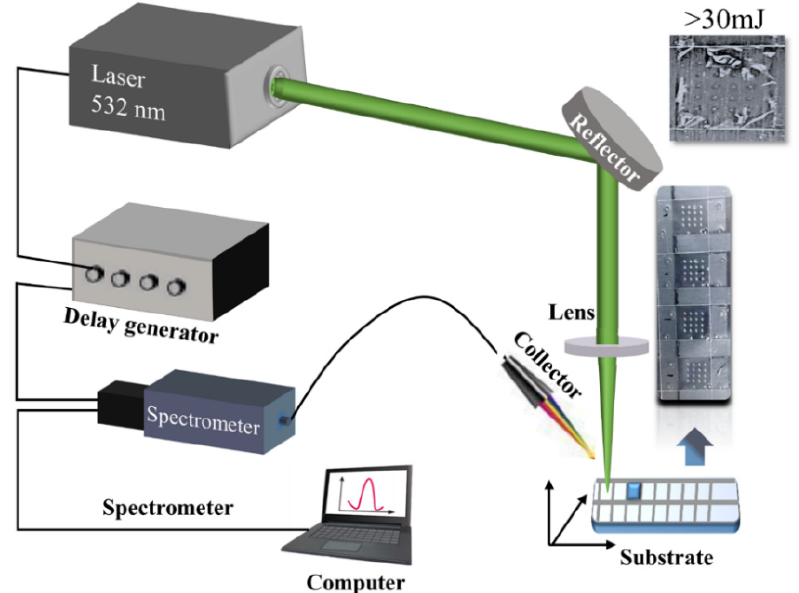
Figure 3. The schematic diagram of the LIBS experiment.